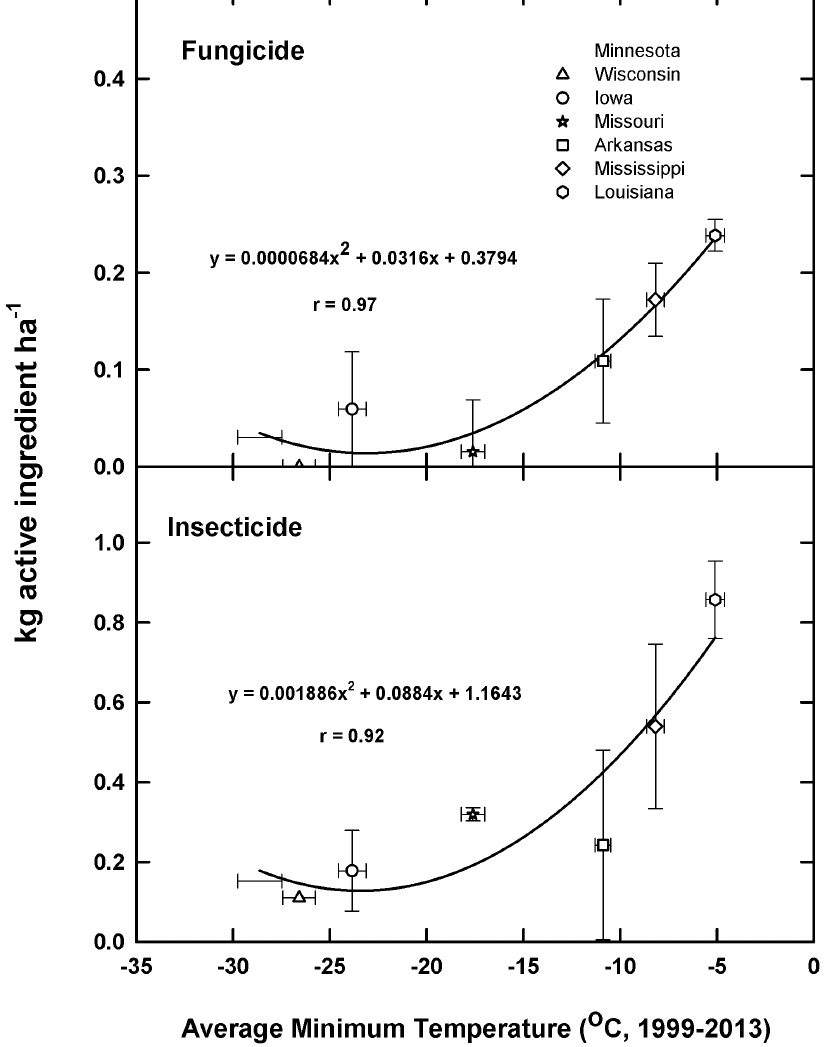
Figure 1. Minimum temperature by state averaged for the period 1999–2013 as a function of insecticide and fungicide usage (kg active ingredient, ai, per hectare) as determined from the National Agricultural Statistical Service survey for the years 1999, 2000, 2001, 2002, 2004, 2006, and 2012) for a north-south transect of seven Midwestern states where commercial soybean is grown. Minimum temperatures were determined as the lowest recorded temperature for a 24 h period during a given calendar year for four locations for a soybean growing area within a state. Lines represent the ‘‘best fit’’ second order polynomial. Bars are 6 SE. See Methods for additional details.